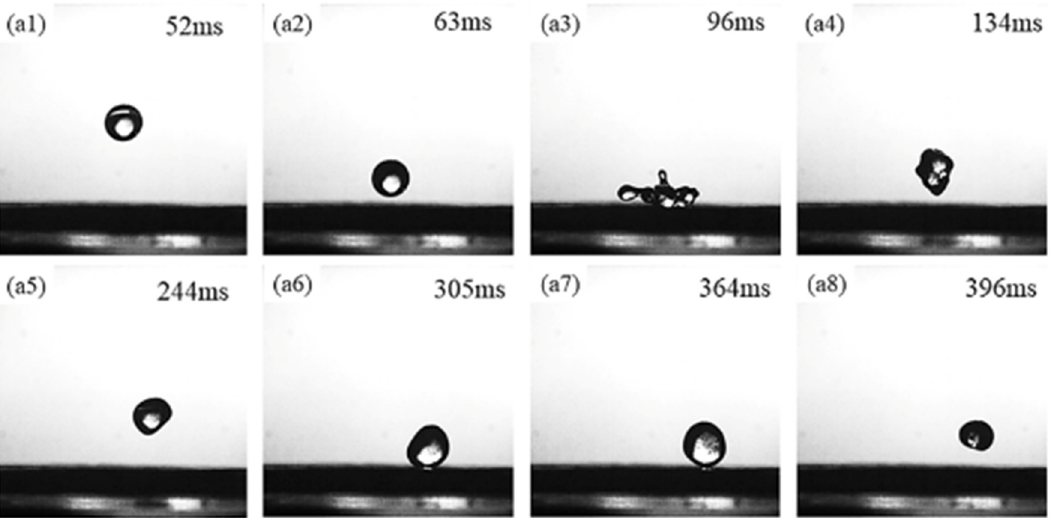
Figure 5. Delayed images of the water droplet bouncing phenomenon taken on the prepared super- hydrophobic coating.